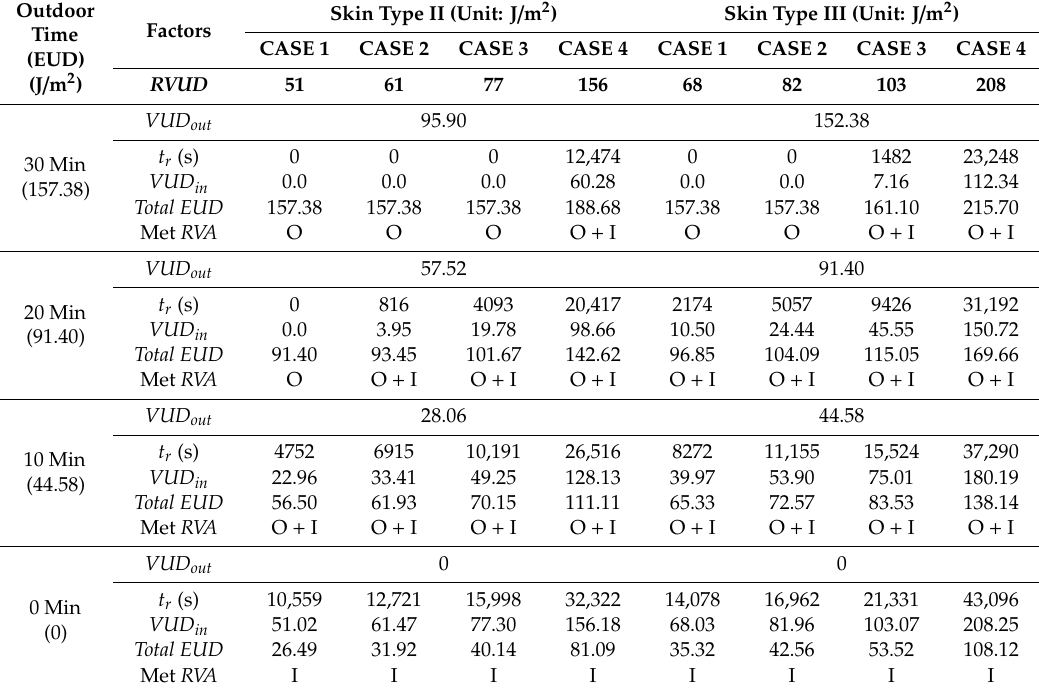
Table 3. Comparison of UV exposure amount according to the duration of outdoor activities of the user. Outdoor